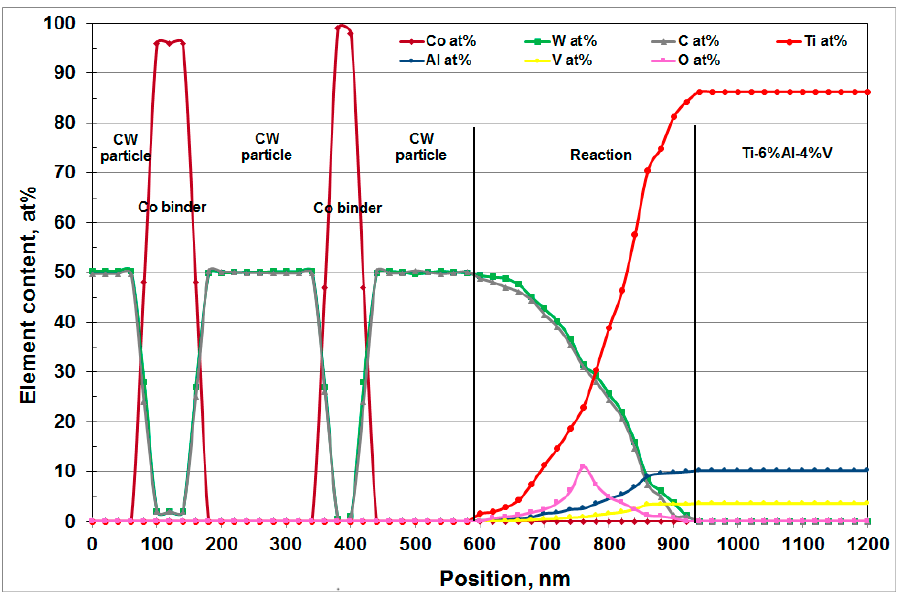
Figure 20. Auger microprobe analysis of the contact area between the chip and the carbide tool (line L).